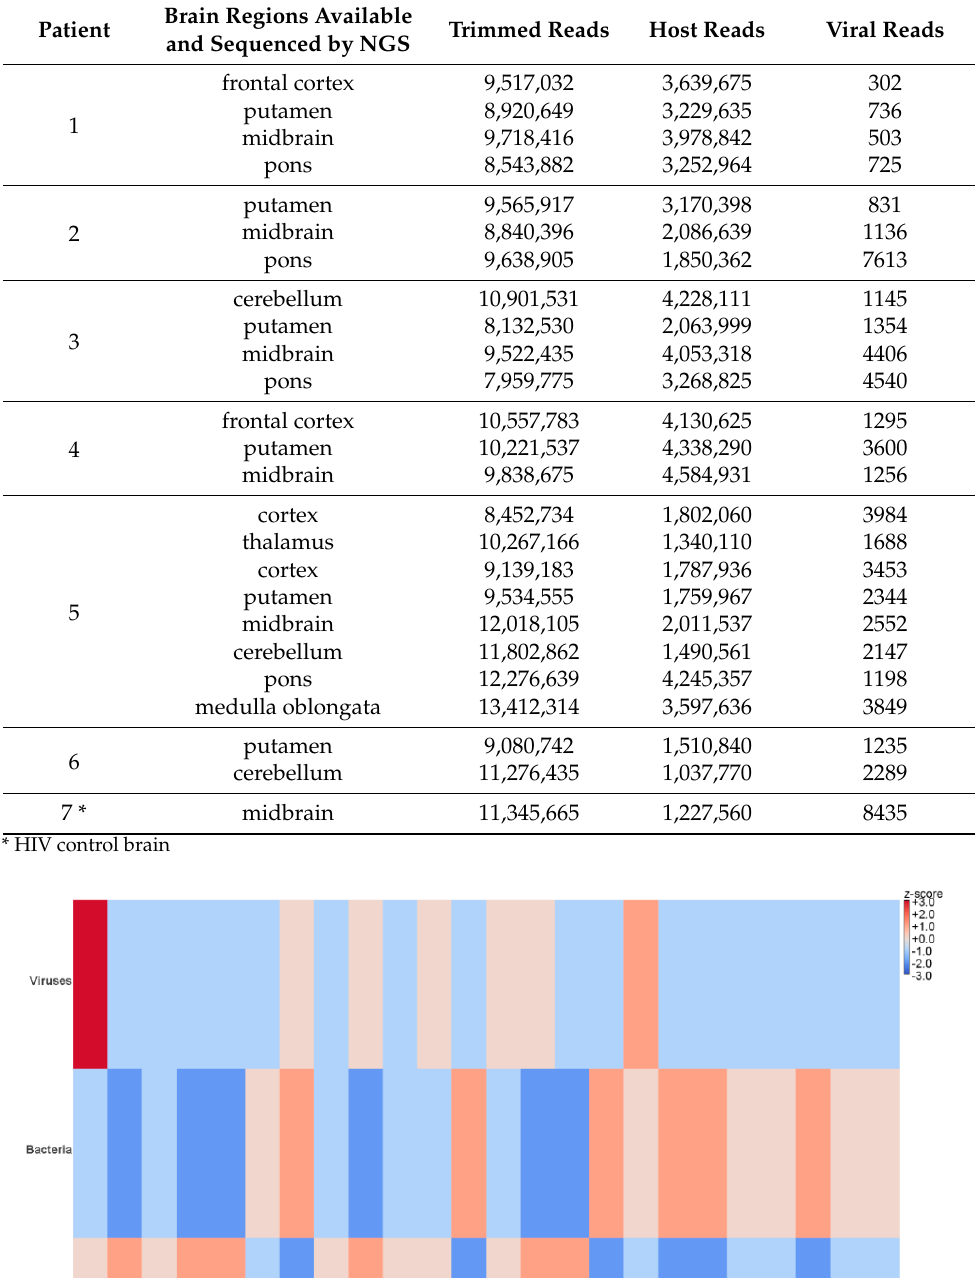
Table 2. Host and virus reads from transcriptome sequencing data of patient brain sections.